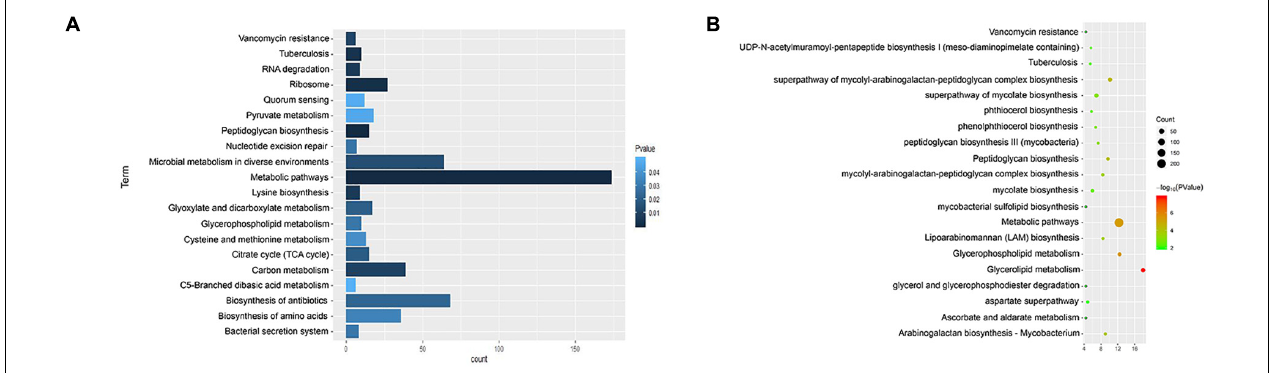
FIGURE 1 | Enrichment of cell wall-related gene pathways in the standard strain of M. tuberculosis H37Rv. (A) The top 20 pathways with the lowest p -values ( < 0.05) for KEGG were selected and a histogram was created. (B) The top 20 pathways with the lowest p -values ( < 0.05) for Biocarta, KEGG, NCI-PID, HumanCyc, and Reactome are shown in a bubble chart.